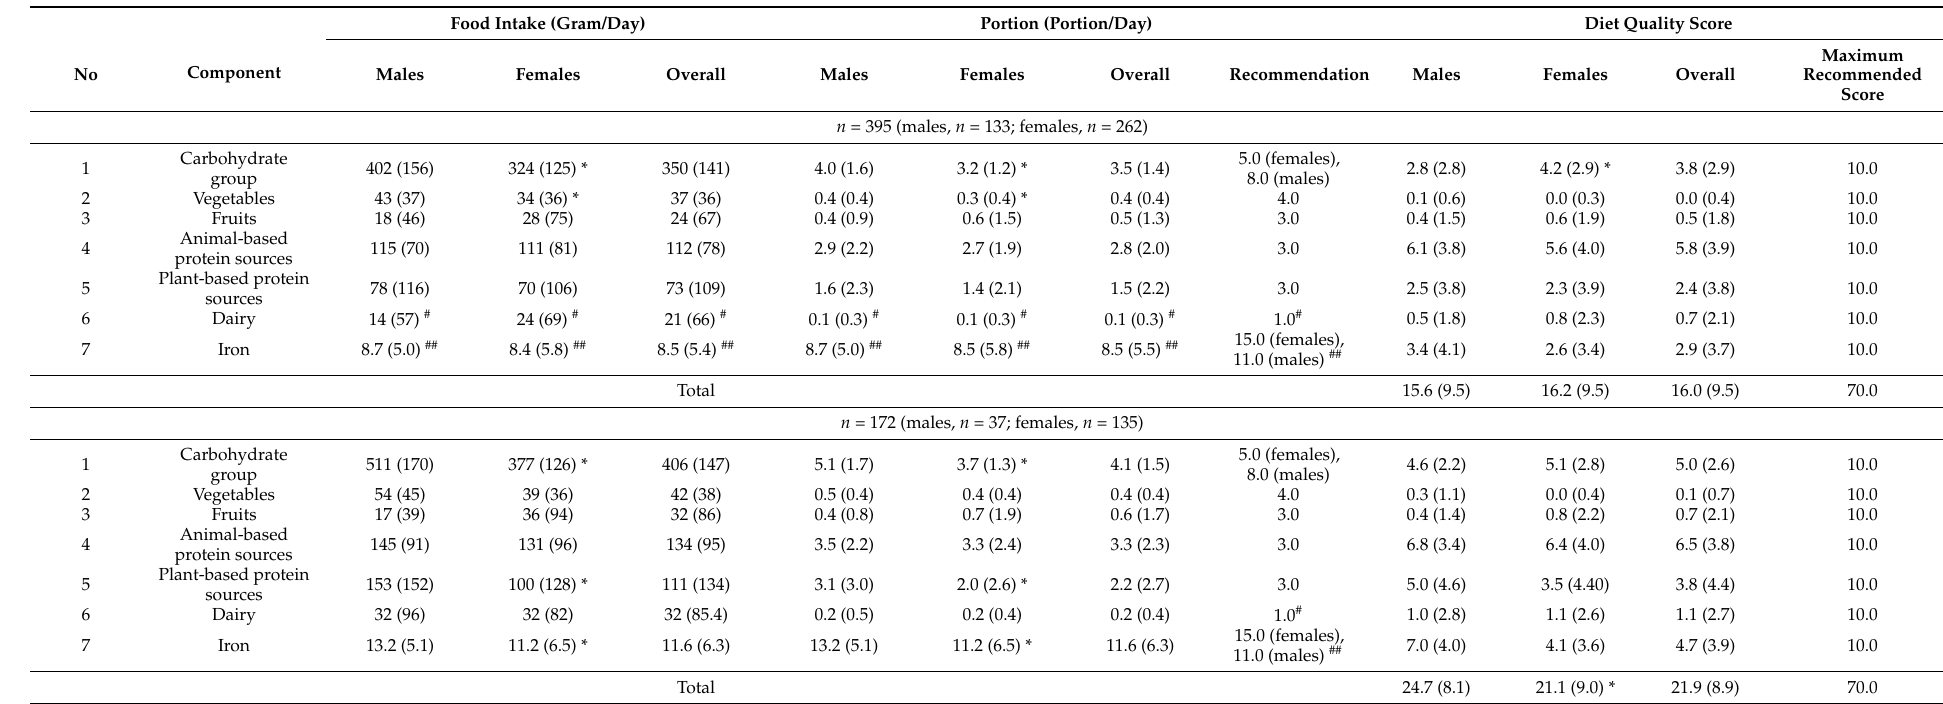
Table 4. Food intake, portions, and diet quality score in the